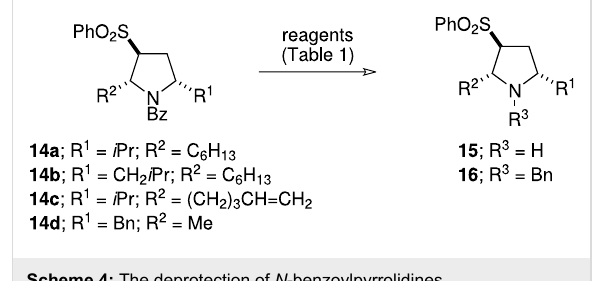
Scheme 4: The deprotection of N